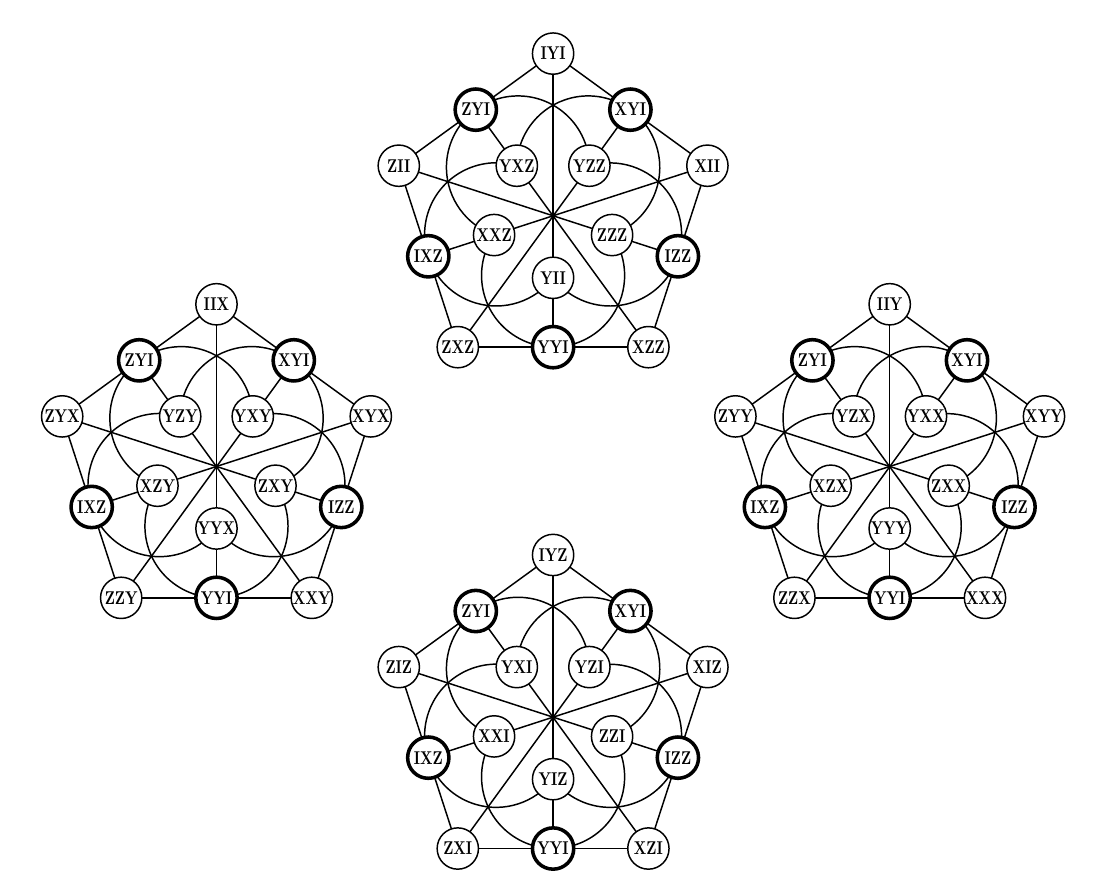
Figure 5. An illustration of the case when four different doilies share an ovoid (boldfaced). The top doily is of Type 11, the bottom one of Type 8, and both the left and right doilies are of Type